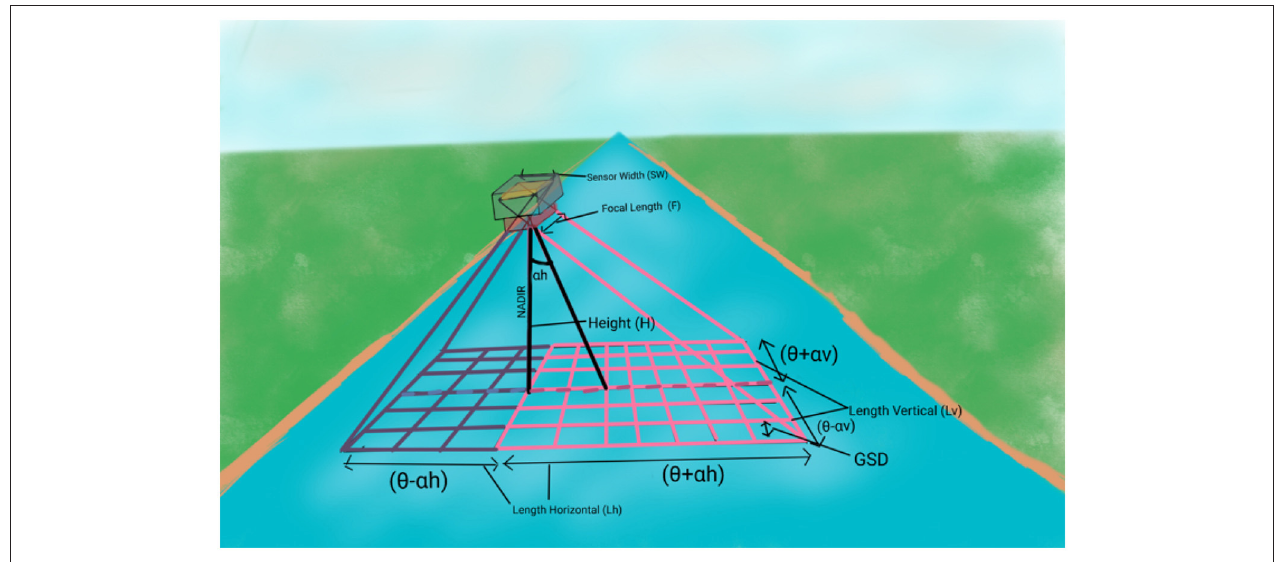
FIGURE 5 | Schematics of GSD at an oblique